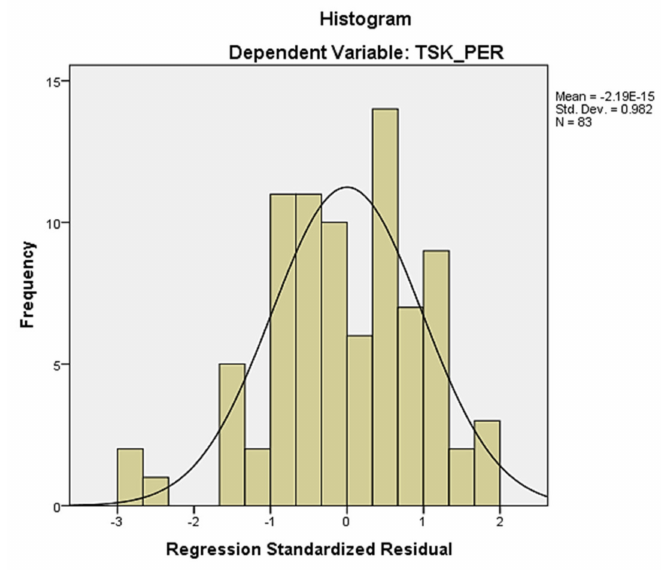
Figure 7. Normality distribution curve.